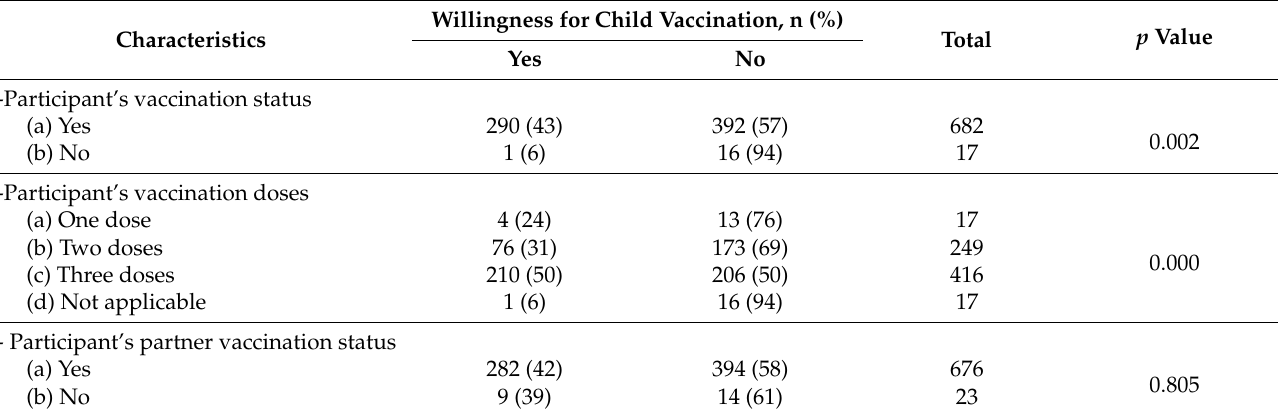
Table 5. Comparison of willingness for child vaccination with vaccination status of the family.